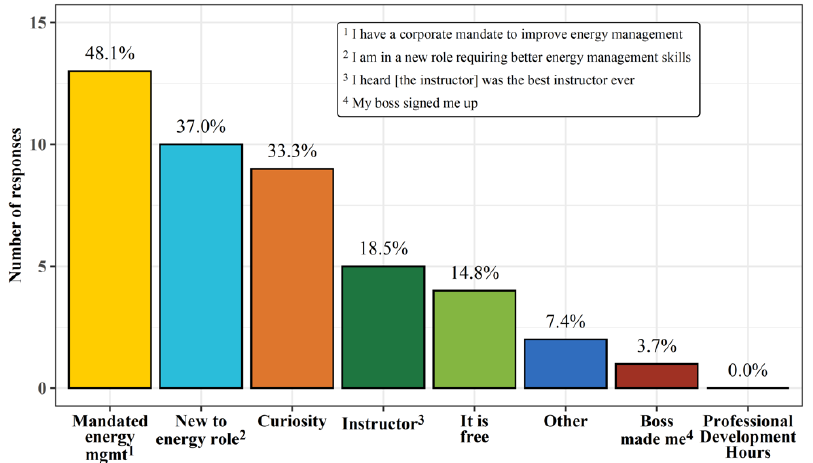
Figure 1. Reasons for attending the training (source: based on the polling survey